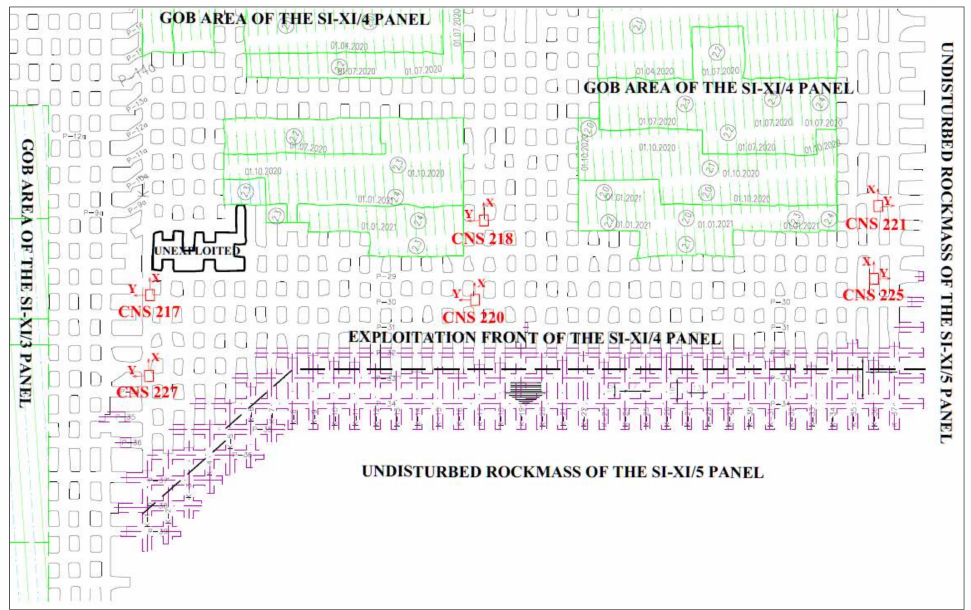
Figure 7. Location of measurement stations against the background of mining excavations at the completion time of the